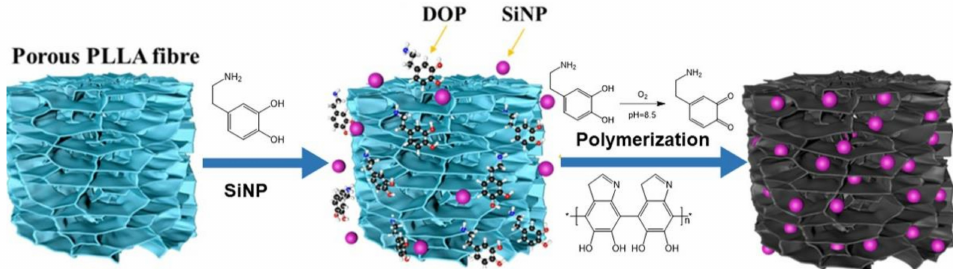
Figure 5. The surface of PLLA fiber is modified by DOP. With polymerization of PDA made from DOP via oxidative self-polymerization, the interaction between PLLA fibers and SiNPs is built. Reprinted from [30], with permission from Elsevier. © 2021 Elsevier B.V. All rights